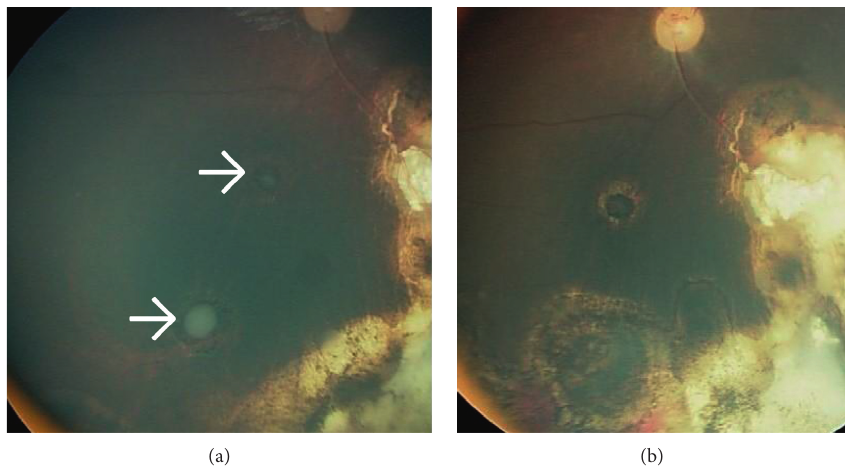
Figure 2: Regression of vitreous seeding: (a) cloud vitreous seeds that totally diasapperaed after 4 injections of intravitreal melphalan cyhemotherapy. (b) An example of type 0 regression pattern where vitreous seeds completely